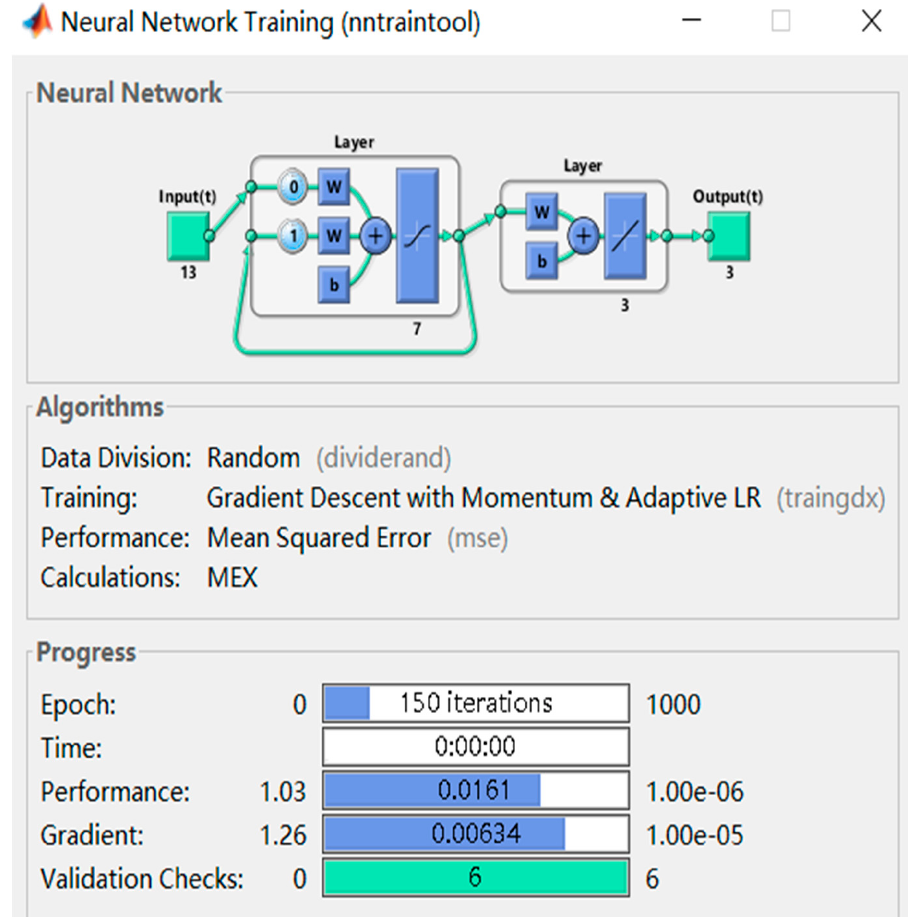
Figure 4. Physical world and digital twins.